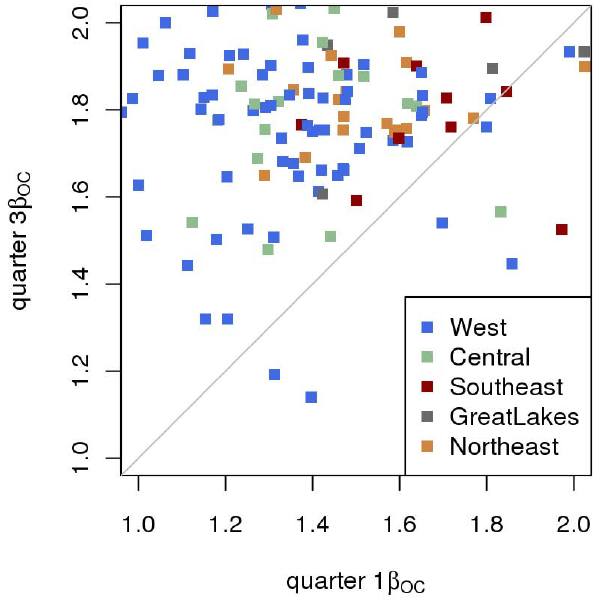
Fig. 12. Comparison of β OC values for quarters 1 and